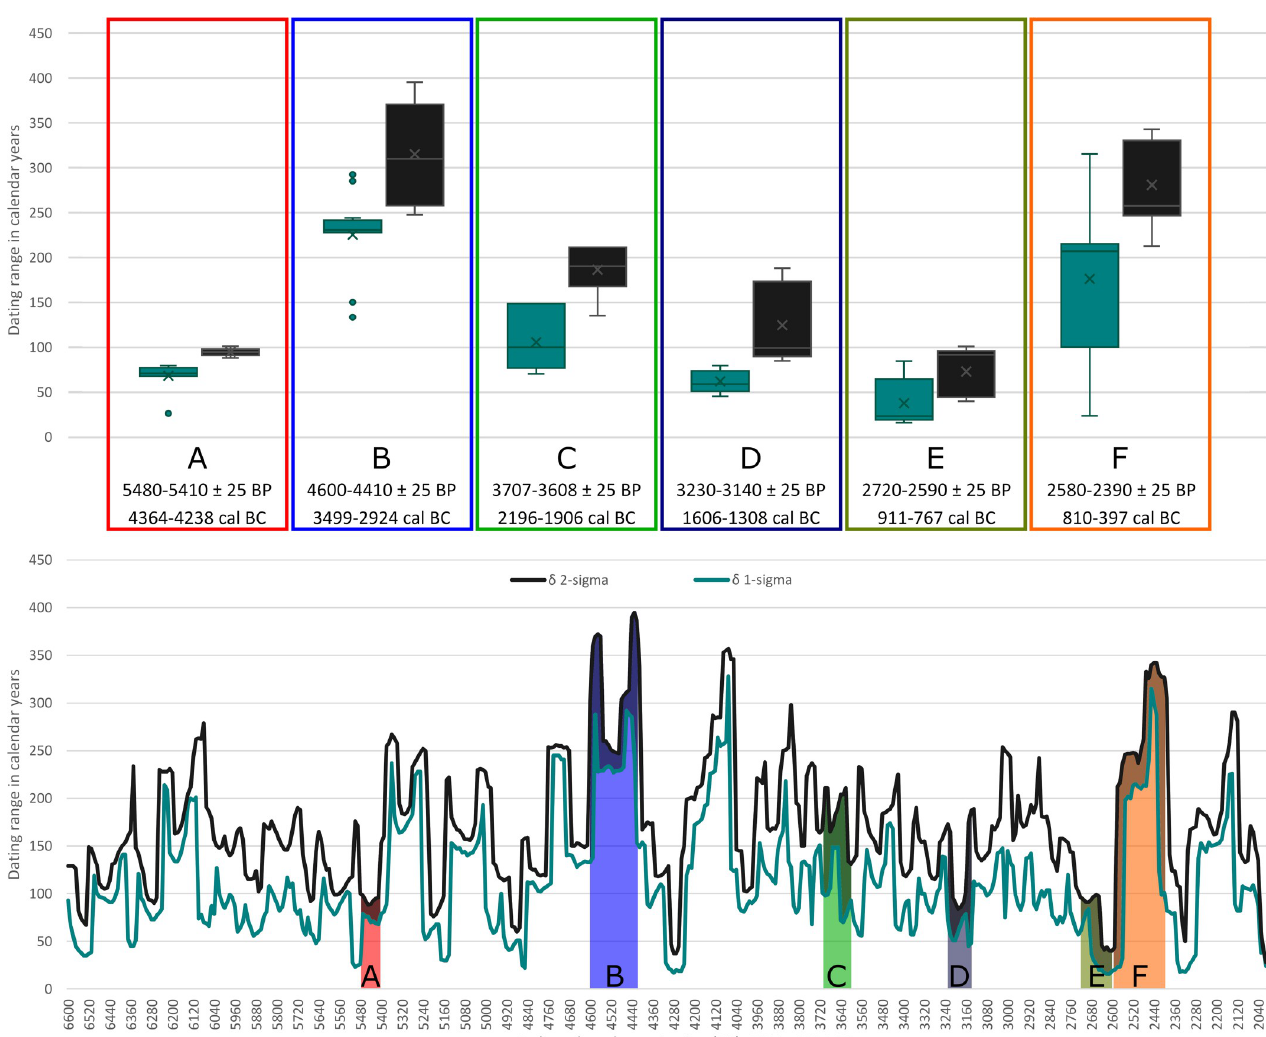
Fig 1. Ranges of calibrated radiocarbon dates from 6600–2021 BP. The compilation of calibrated radiocarbon dates (using the IntCal13 dataset) with regular intervals of 5 years (ca. 5600–1 cal BC: The Early Neolithic to the beginning of the Common Era in Central Europe) and with an uncertainty of +/- 25 years represent a typical uncertainty of modern AMS-dating laboratories. Representative sections of the calibration curve are chosen (A-F) to illustrate variations in their overall dating ranges (bottom panel) and differences between their 1- and 2-sigma ranges (Whisker-Box-plots in the upper panel). A: Steep sections of the calibration curve (5480–5410 BP); B: Extensive plateau section in the Neolithic period (4600–4410 BP; cf. Meadows et al. 2020 [5]); C: Early Bronze Age mixed section corresponding to our case studies (3700–3600 BP); D: Middle Bronze Age section with significant differences between 1- and 2-sigma ranges (3230– 3140 BP); E: Short steep section of the calibration curve before the Hallstatt plateau (2720–2590 BP); F: Hallstatt plateau with two distinct sub-plateaus (2580– 2390